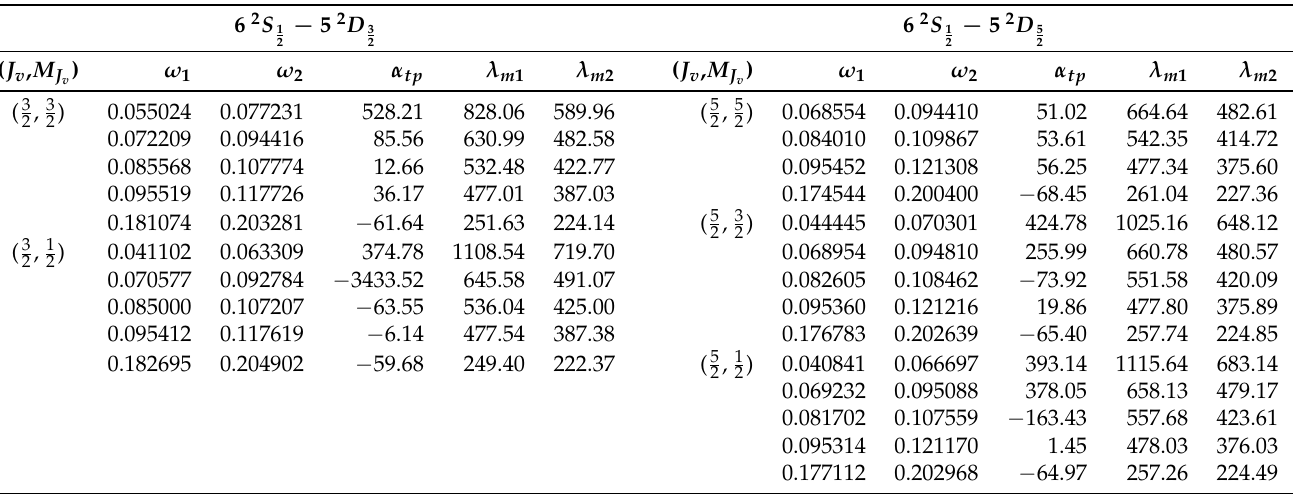
Table 5. Two-photon magic wavelengths ( λ m 1 and λ m 2 ) in nm with two-photon polarizability